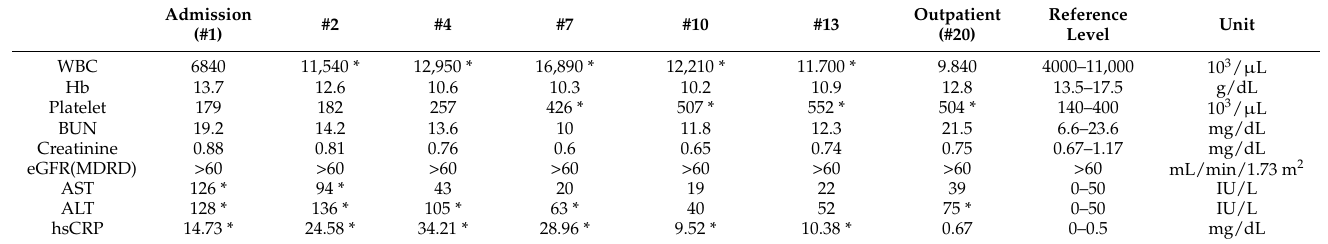
Table 1. Laboratory findings from the time of admission to discharge and at outpatient follow-up.